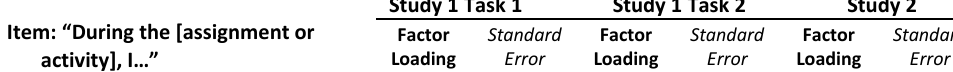
Table A1. Eight-Factor Model WLSMV Confirmatory Factor Analysis Item-Level